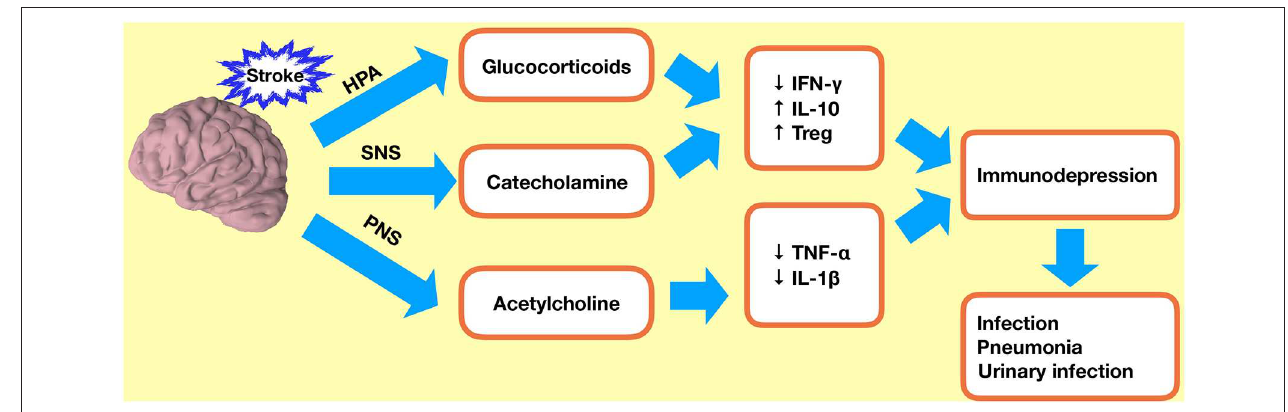
FIGURE 4 | Immunodepression after ischemic stroke. Stroke-induced immunodepression leads to an increased incidence of infections. HPA, hypothalamic–pituitary–adrenal axis; SNS, sympathetic nervous system; PNS, parasympathetic nervous system; Treg, regulatory T